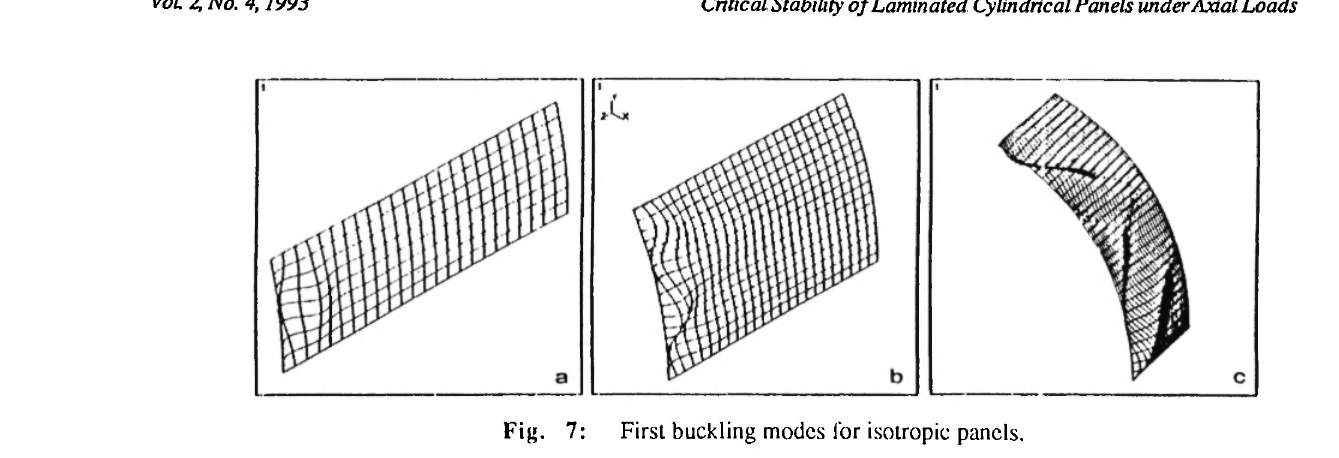
Fig. 7: First buckling modes for isotropic